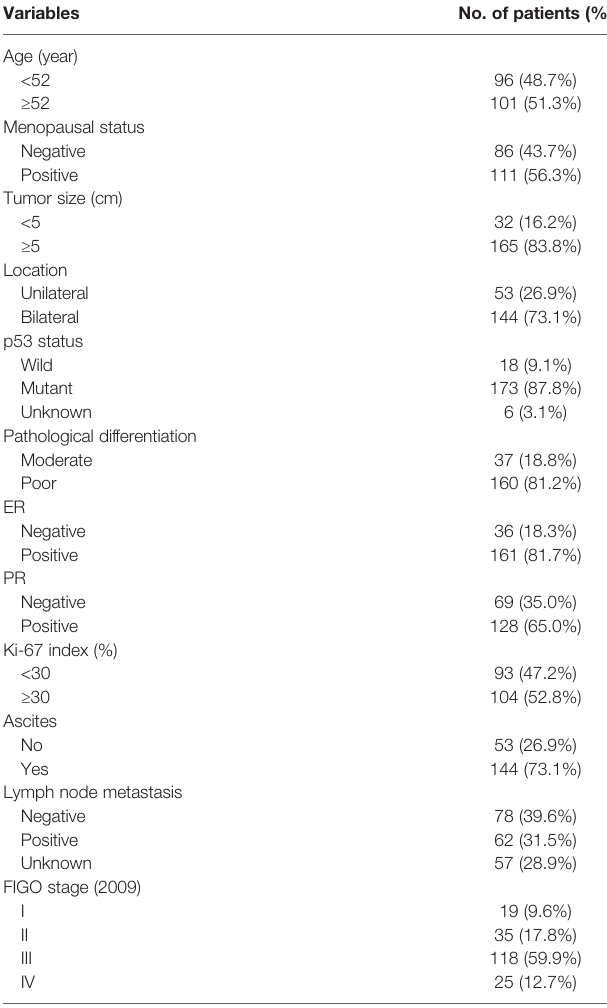
TABLE 1 | Basic clinicopathological characteristics of 197 high-grade serous ovarian cancer patients.